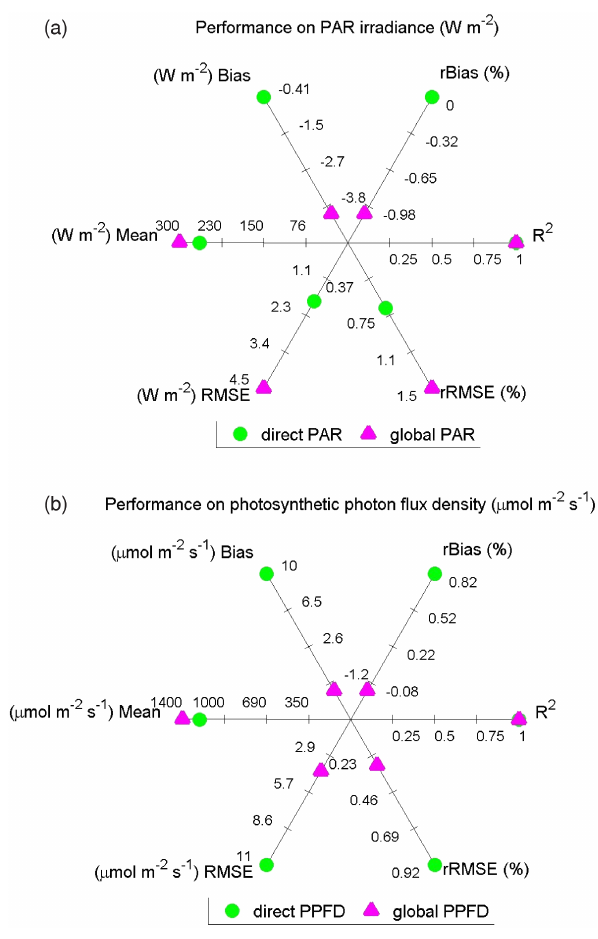
Figure 1. Synthesis of the performance of the proposed